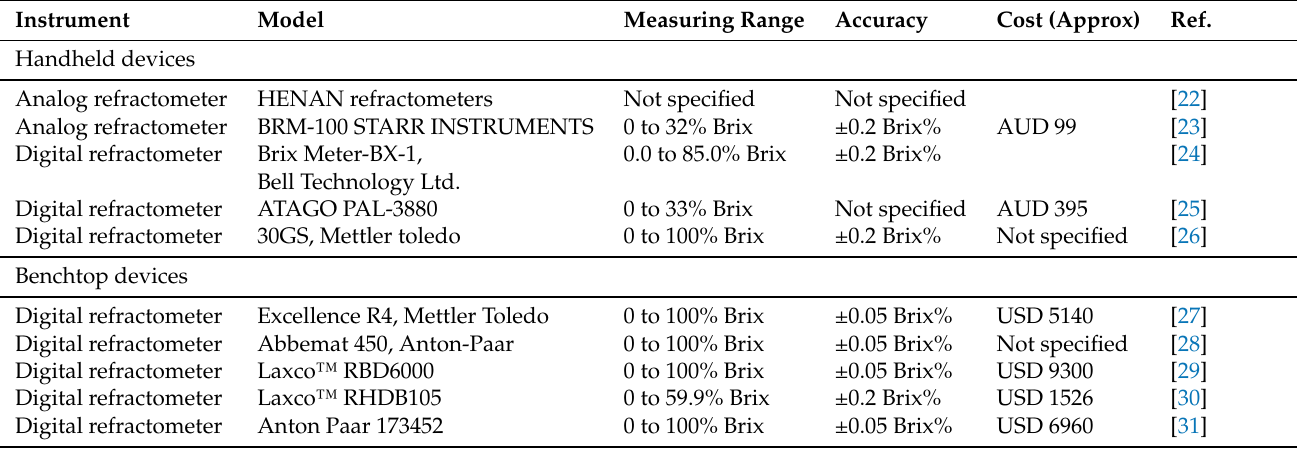
Table 2. An overview of commercial refractometers available in the